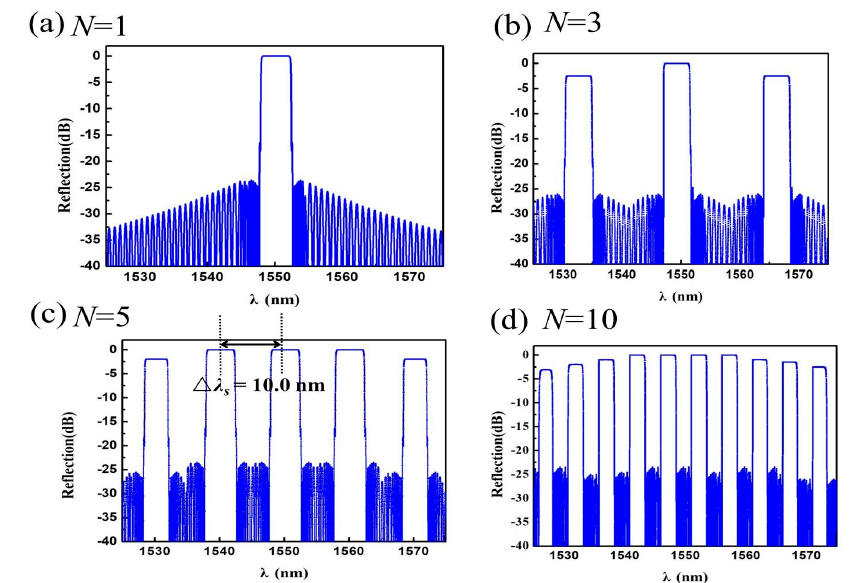
Figure 6. Reflection spectrum of the proposed apodized sampled grating related to N . ( a ) N = 1; ( b ) N = 3; ( c ) N = 5; ( d ) N = 10.